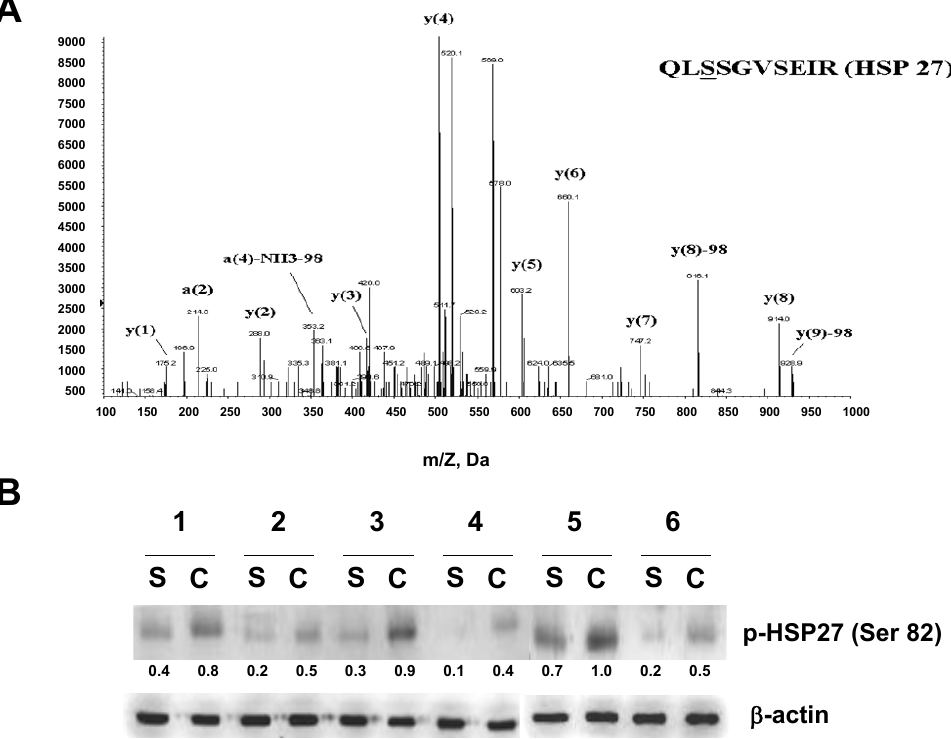
Figure 3. MS/MS profile and immunoblot data of phosphorylated HSP27. ( A ) MS/MS spectrum of phosphorylated HSP27 indicated the phosphorylation site at QLpSSGVSEIR; ( B ) Verification of phosphorylation-HSP27 (Ser-82) by Western blotting analysis. Cholesteatoma is presented by C, and retroauricular skin is presented by S. β -actin was used for